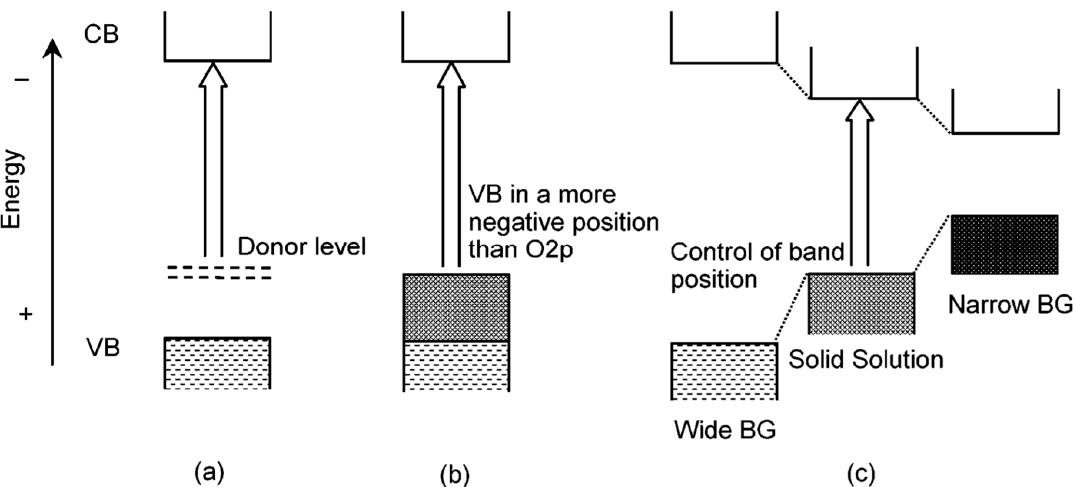
Figure 8. Band engineering through doping and forming solid-solution. ( a , b ) Formation of a new VBM by doping a foreign element to create a donor level, and ( c ) forming solid solution to obtain a controllable bandgap. Reproduced with permission from [64]. Copyright American Chemical Society, 2004.